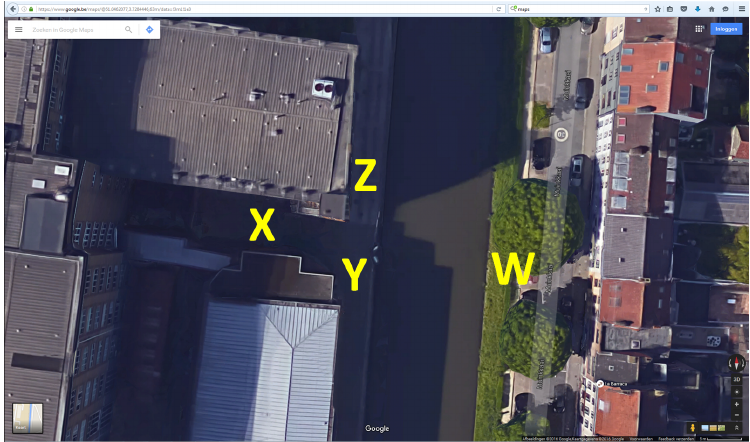
Figure 3. Outdoor measurement area, from Google Maps.